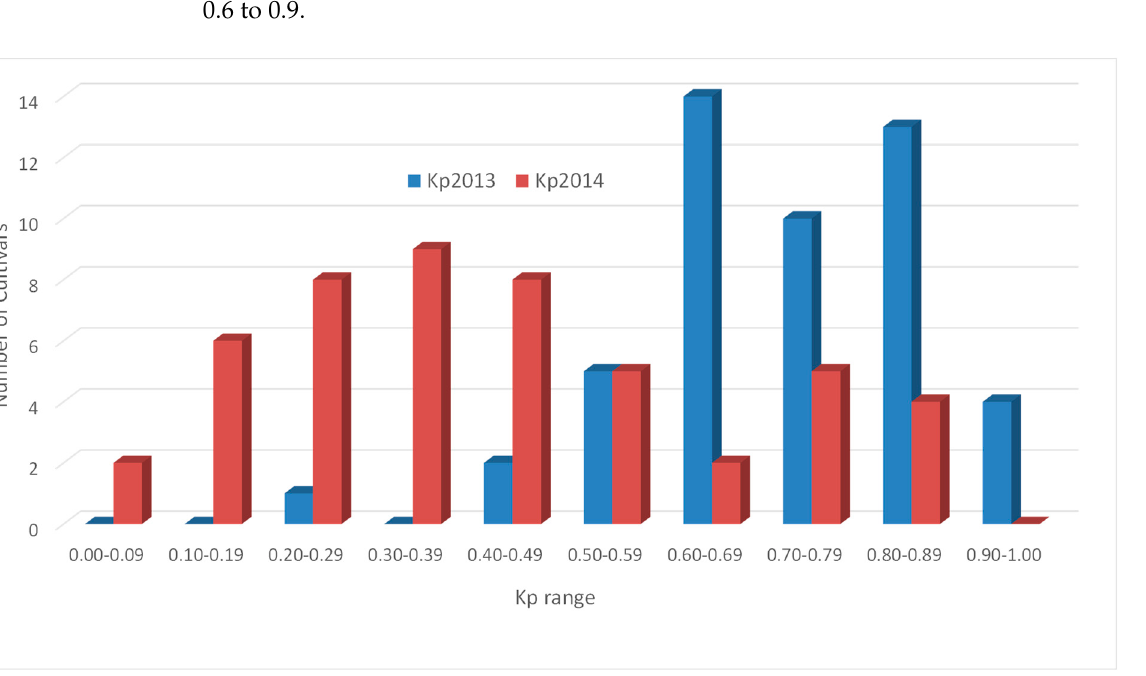
Figure 5. Photoperiod sensitivity index for Chadian dry-season sorghum accessions sown at the Youé research farms in Chad in 2013 and 2014.